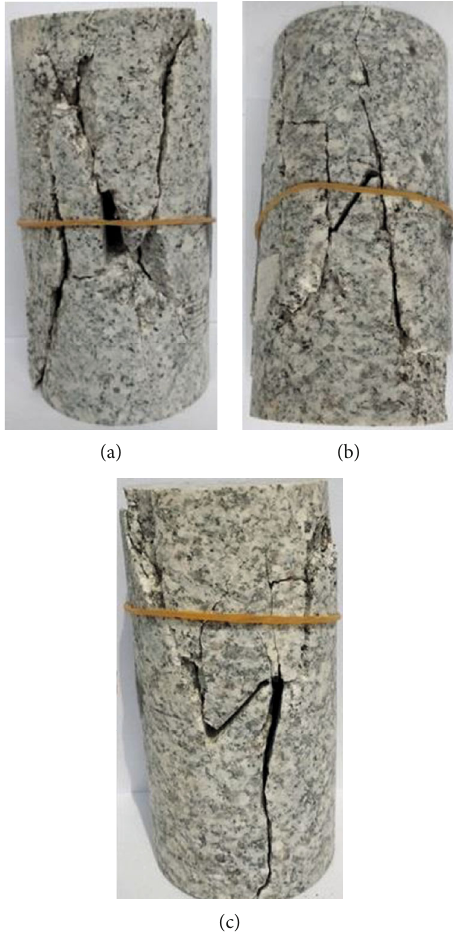
Figure 9: Crack initiation of prefabricated fi ssured granite with di ff erent inclination under the uniaxial compression test: (a) specimen with α = 0 ° , (b) specimen with α = 30 ° , and (c) specimen with α = 45 °